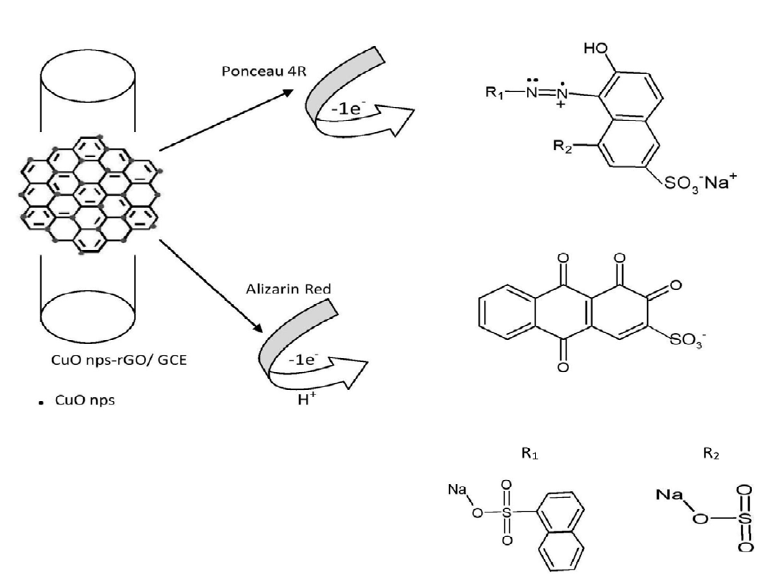
Fig. 10. Plausible oxidation mechanism of (a) Ponceau 4R and (b) Alizarin red dye using CuO NPs–rGO/GCE